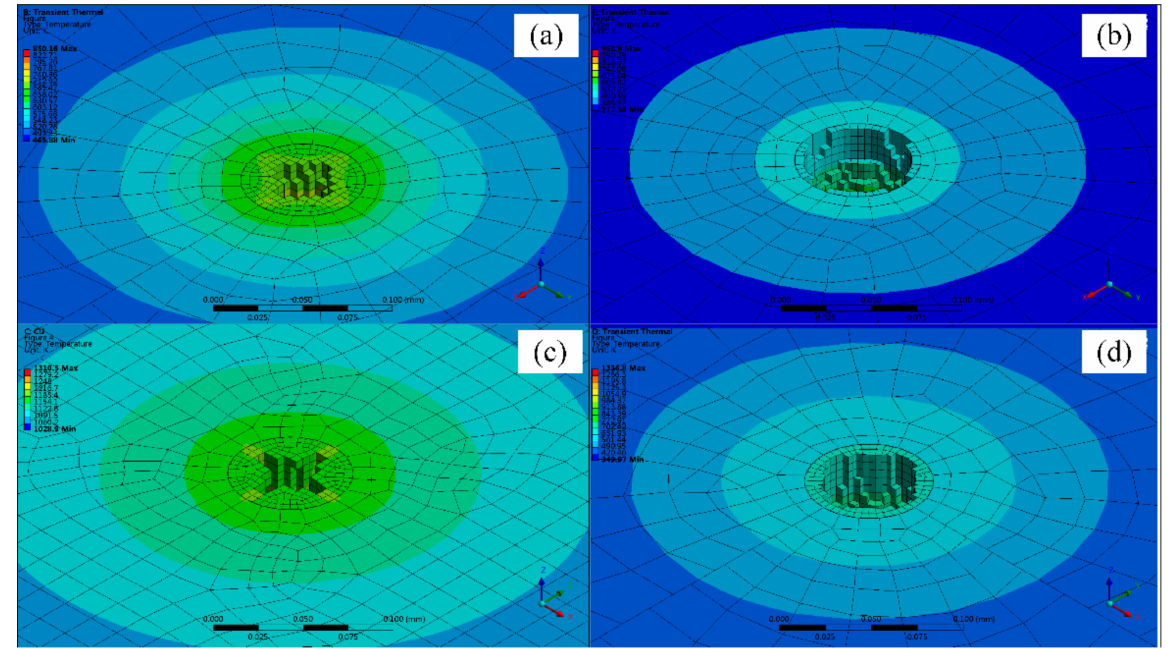
Figure 5. The drilling simulation of hole shape: ( a ) aluminum alloy, ( b ) titanium alloy, ( c ) copper, ( d ) stainless steel.